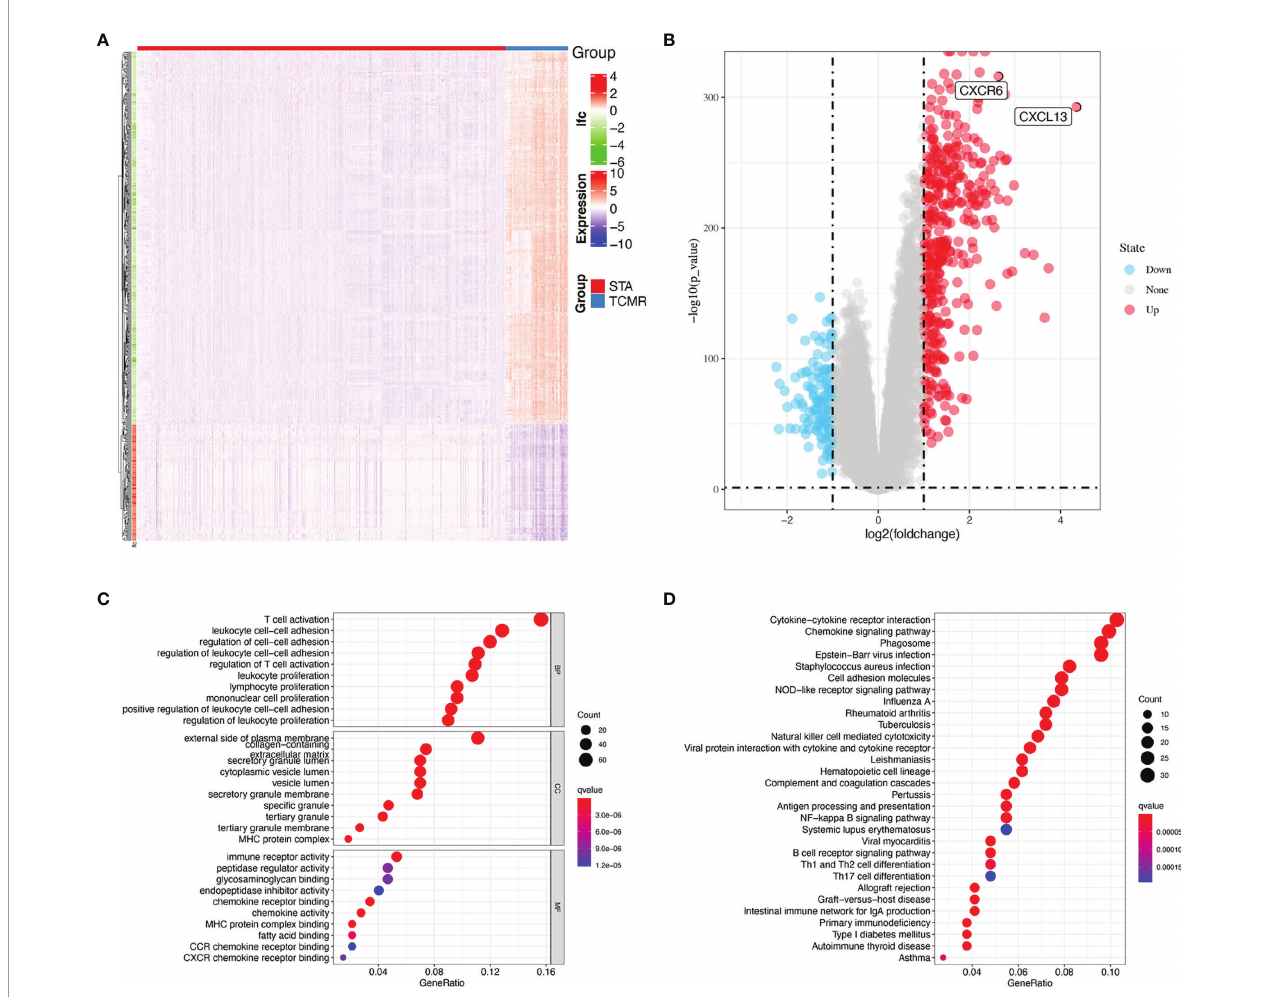
FIGURE 1 | Functional enrichment analysis of DEGs. (A) Heatmap for DEGs between TCMR and STA group. (B) Volcano plot for DEGs. (C) KEGG analysis on DEGs. (D) GO analysis in